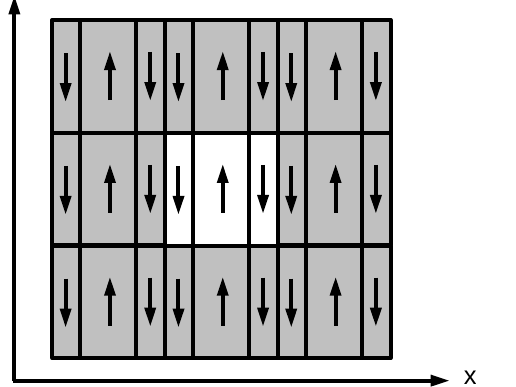
Figure 1. Computational domain is a white square duplicated along the x and y axes. For Ni 2 MnGa , saturation magnetization is M s = 6.015 anisotropy constant is K anis = 2.5 2 10 − 11 J/m ×